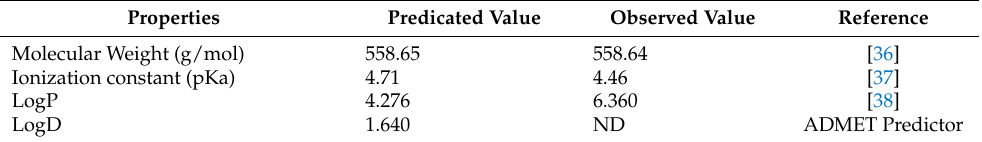
Table 1. Estimated physicochemical and pharmacokinetic properties of Atorvastatin from ADMET Predictor. ND not